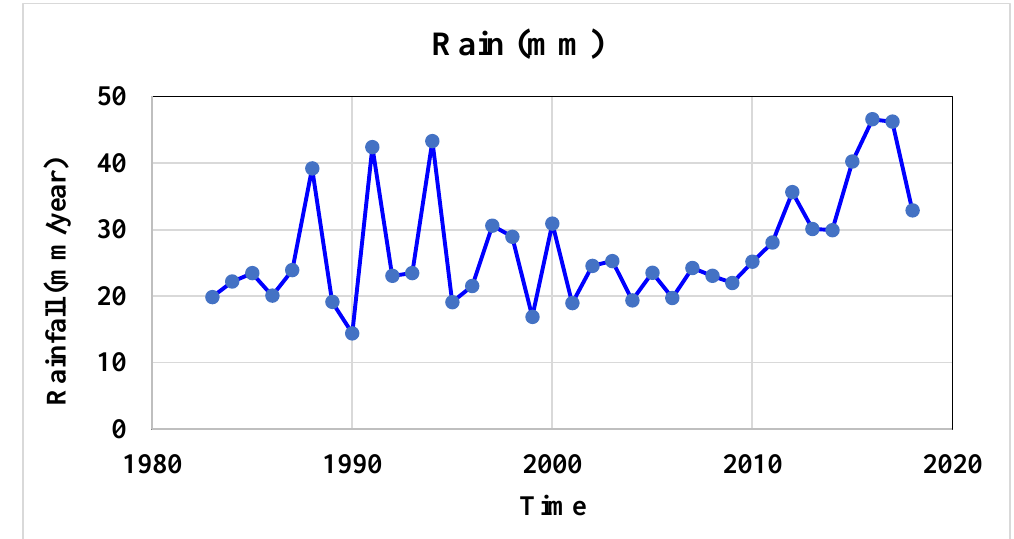
Figure 2. Rainfall estimates from the Precipitation Estimation from Remotely Sensed Information using Artificial Neural Networks—Climate Data Record (PERSIANN-CDR) satellite data from 1983 to 2018 over Egypt, showing an increasing trend of annual rainfall over all of Egypt.